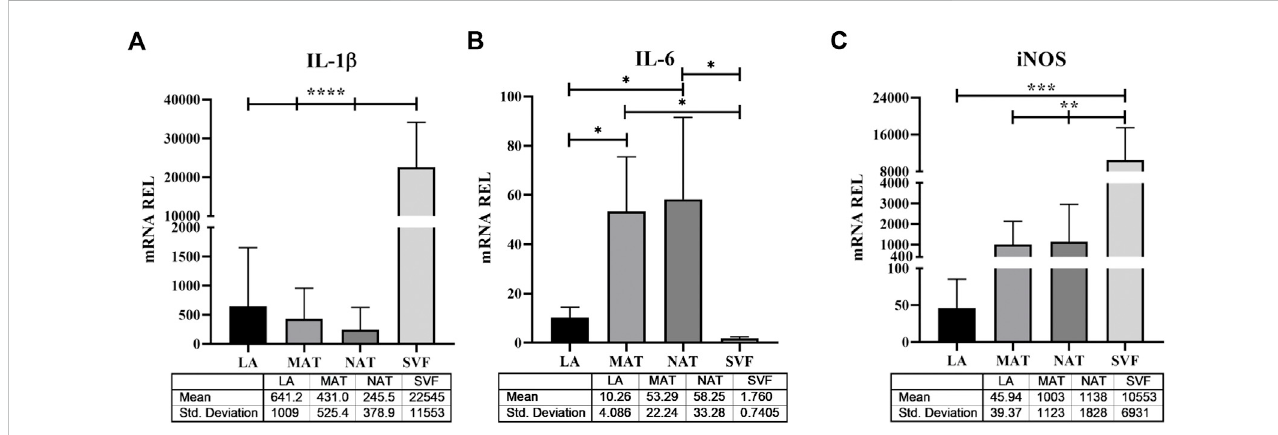
FIGURE 6 Stress related genes expression in lipoaspirate (LA), micro-fragmented (MAT), nanofat (NAT) and stromal vascular fraction (SVF) samples. (A) Interleukin ( IL ) -1 β gene expression levels; (B) IL-6 gene expression levels; (C) Inducible nitric oxide synthase ( iNOS ) gene expression levels. Results are expressed as relative quantity (mRNA REL) of gene levels calculated by the 2 − Δ DCt method, where the value one was assigned to the lowest level of expression. * p ≤ 0.05; ** p ≤ 0.01; *** p ≤ 0.001; **** p ≤